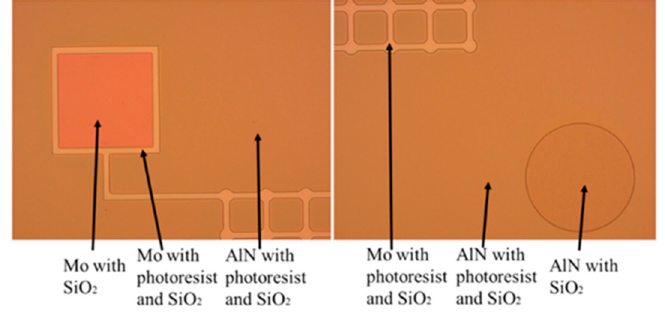
Figure 9. Optical microscope images of wafer surface photoresist at electrode pads. ⑥ The bottom electrode pad is etched. Silicon dioxide is used as a mask; AZ400K is used as an etching solution, and a dilute aqueous solution of AZ400K:H 2 O = 1:4 is used to etch aluminum nitride at 65